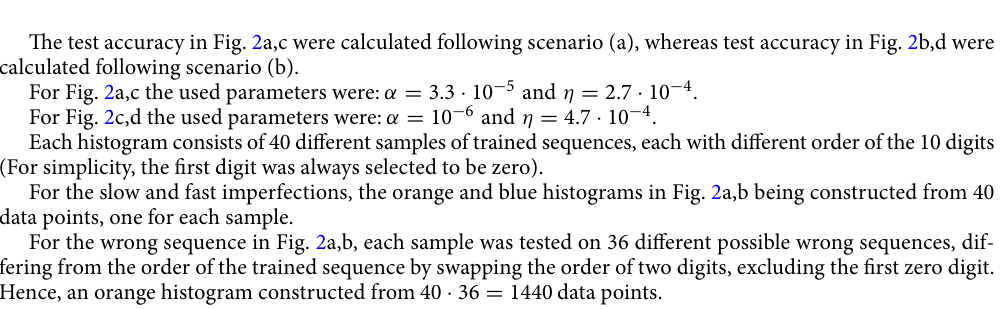
Figure 2: The calculation of the SRs. The ID-net SRs are calculated based on a minimum of 200 sequences with the same order of the 10-digits as in the training procedure. We distinguished between the following two scenarios: a. The trained network knows the order of digits in the sequence. Hence, the SR for each one of the 10 presented digits is calculated with respect to the expected digit, even if a wrong sequence was presented (Fig. 1e). b. The trained ID-net does not know the order of digits in the trained sequences. In this scenario, for each one of the 10 presented digits in the test sequence the SR is taken as the maximal SR among the 10 possible output units, regardless if the predicted digit differs from the embedded digit in the trained sequence.